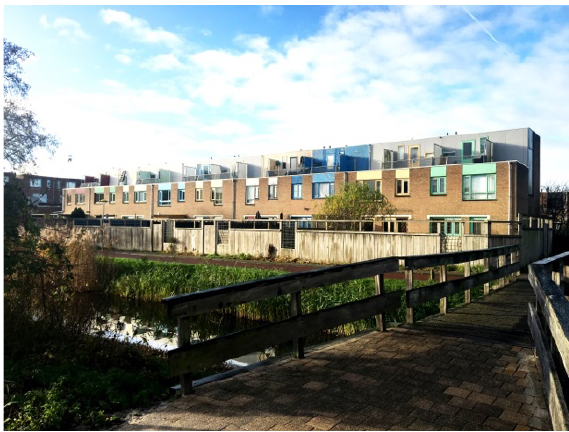
Figure 21. Waterwijk (phase 1): view of flat-roofed row houses. Source: authors.